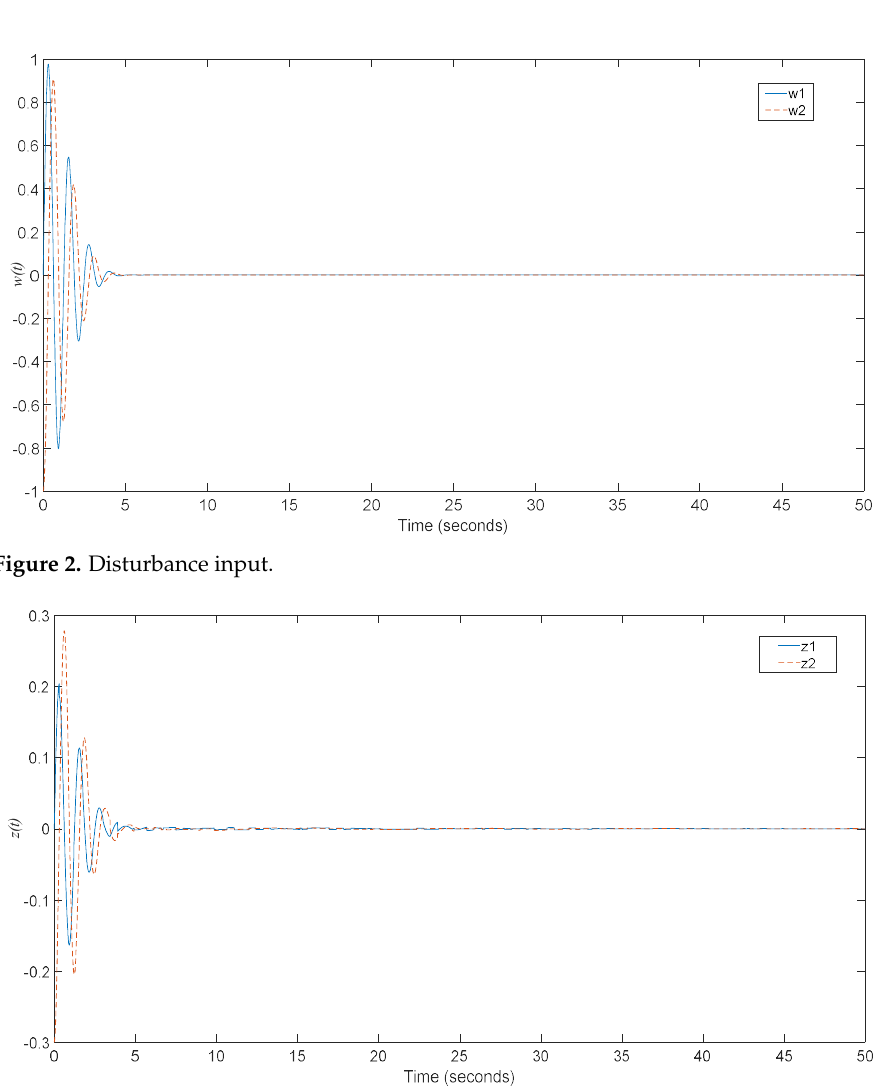
Figure 1. State trajectories of system (1) for the synchronous signal in (29) and sampling input in (30).